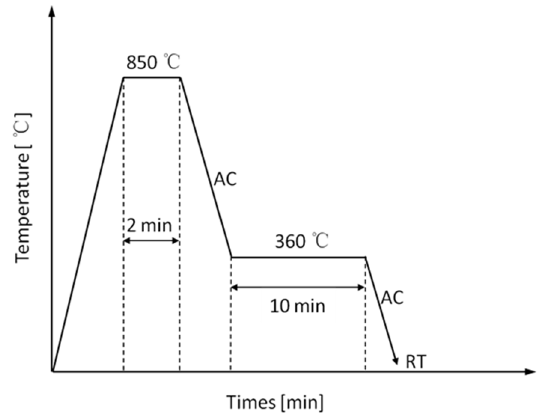
Figure 1. Schematic diagram of continuous annealing.